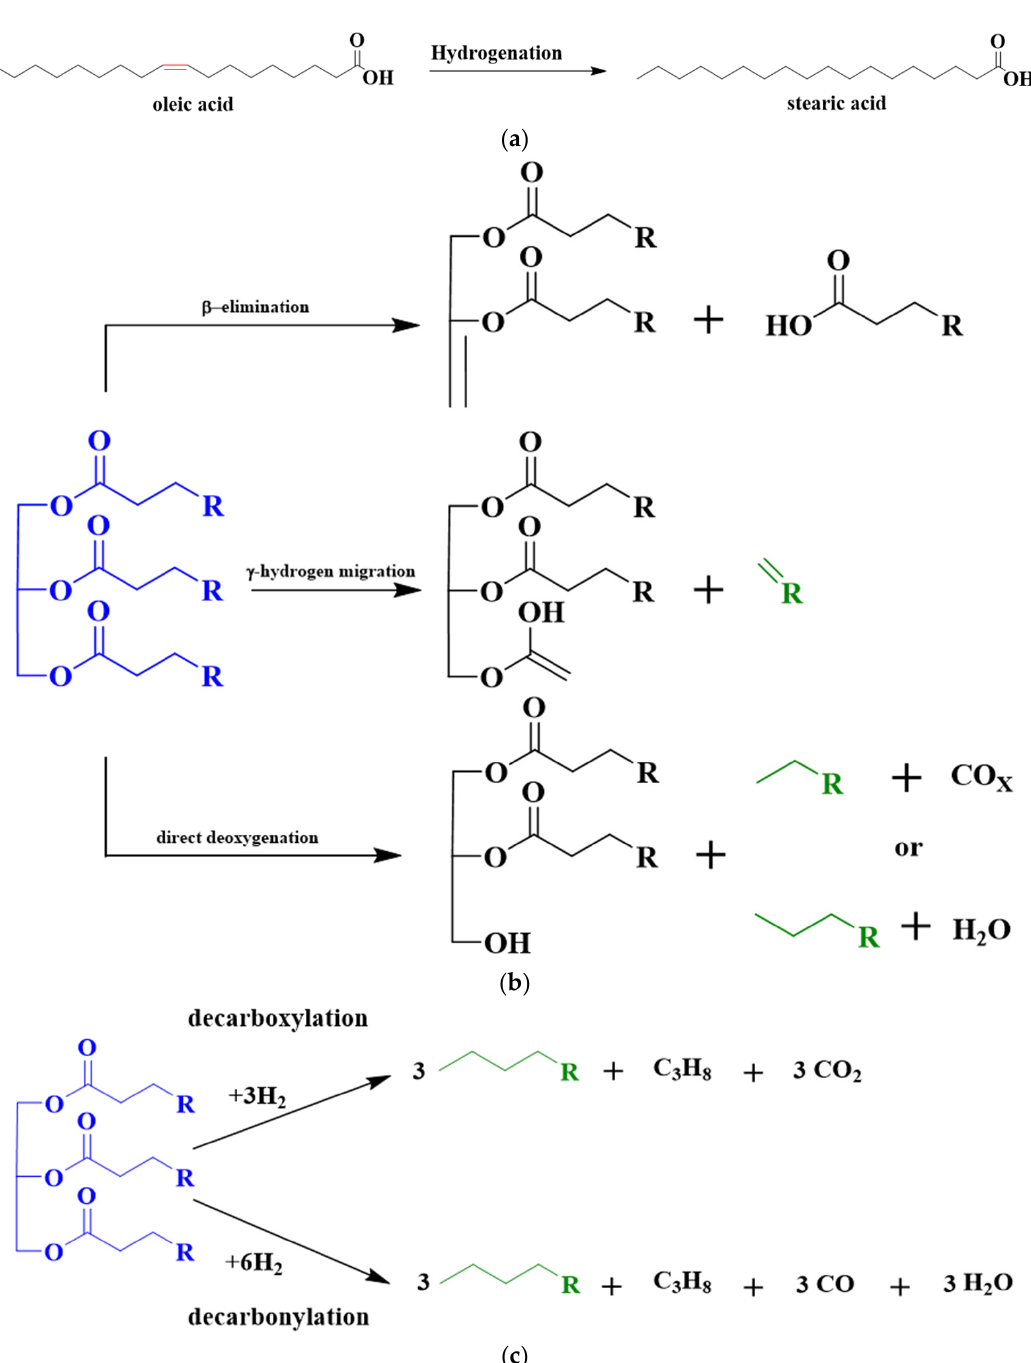
Figure 3. Hydrodeoxygenation of triacylglycerols through hydrogenation ( a , b ), decarboxylation and decarbonylation ( c ).